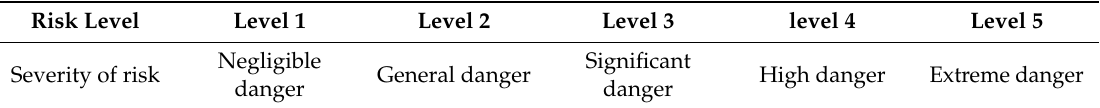
Table 4. Subway construction safety risk sources.